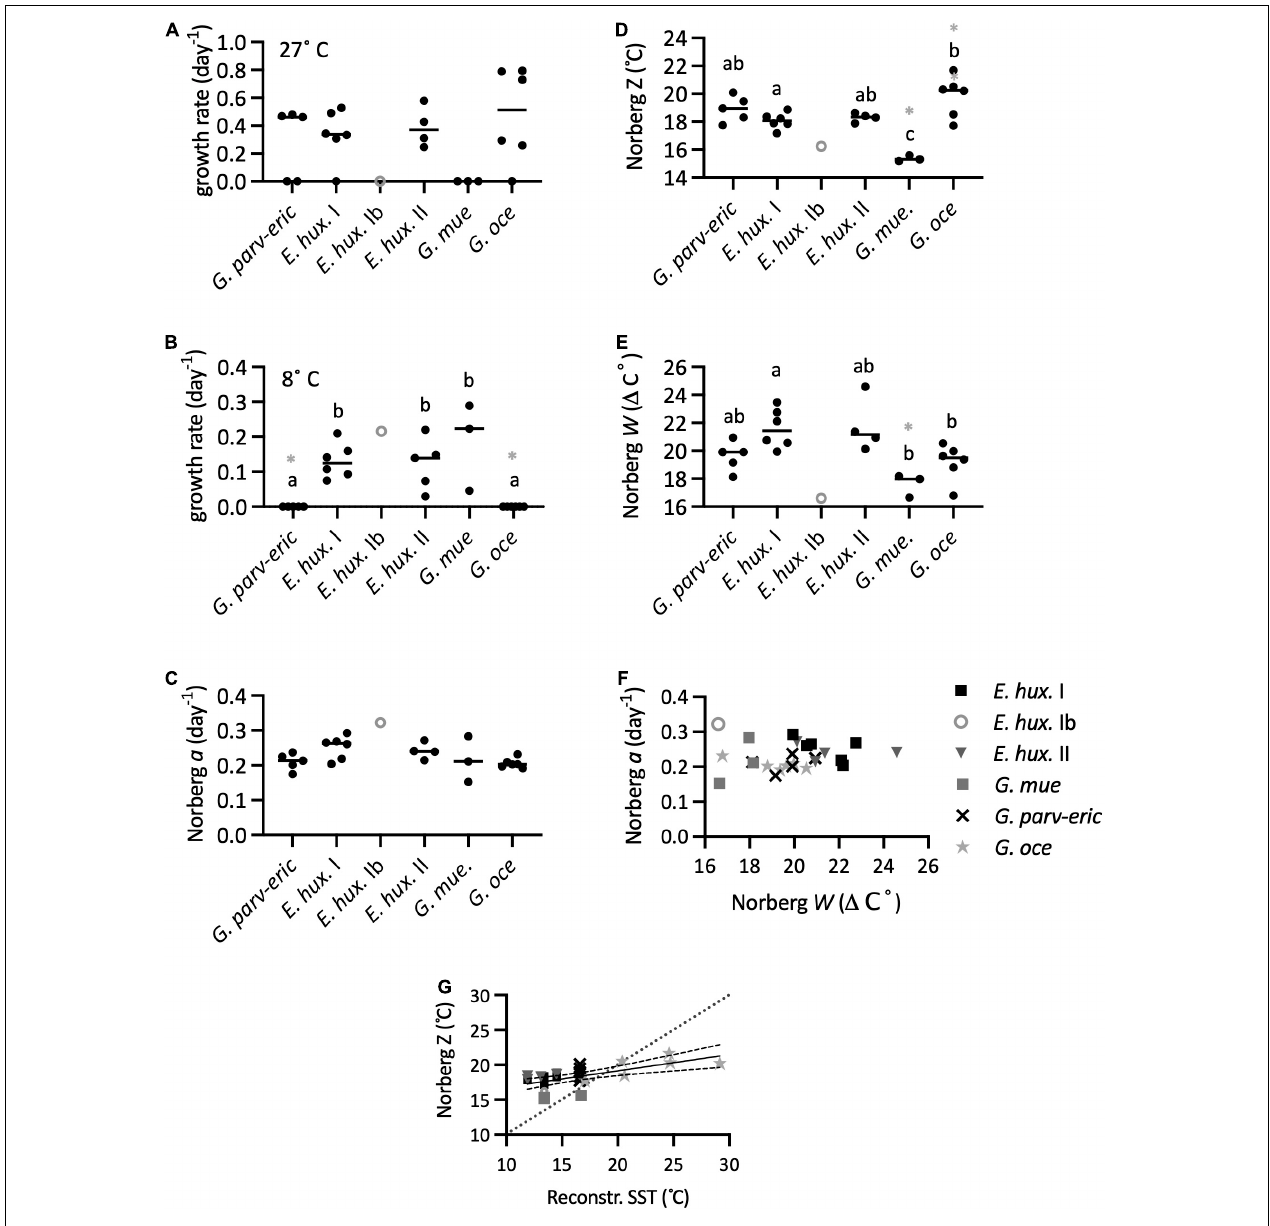
FIGURE 6 | Thermal reaction norms calculated from TPCs in Experiment 1. (A) Growth at 27 ◦ C. (B) Growth at 8 ◦ C. (C) The Norberg a growth (height) parameter. (D) Norberg Z (competitive optimum temperature). (E) Norberg niche width W . Letters indicate significant differences among groups, and groups that share one or more letters were not significantly different in pairwise tests. The single strain of E. huxleyi Ib was excluded from ANOVA tests except when all E. huxleyi were consolidated. A gray + indicates groups which were significantly different from consolidated E. huxleyi , while a gray x indicates when either the G. parvula-ericsonii or G. oceanica differs from G. muellerae in tests with consolidated E. huxleyi . (F) Norberg growth (height) a vs. width W for Experiment 1. (G) Norberg Z vs. reconstructed SST at origin. The linear regression with 95% confidence bands is shown ( F 1 , 23 = 15.64, p = 0.0006, R 2 = 0.4048; equation: Z = 0.2316 × SST + 14.51), and for comparison the 1:1 line is also